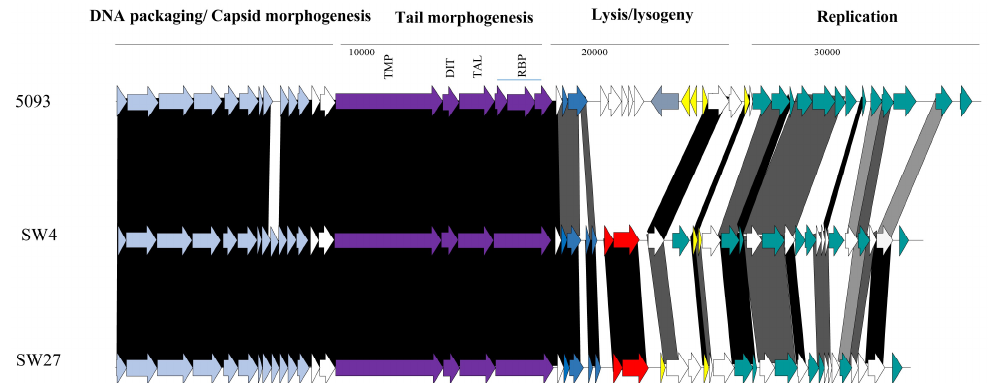
Figure 3. Genomic comparisons of representative 5093 phages from this study and the namesake of the group, 5093. The functions of the gene modules are indicated above the diagram and correspond to the colour-coded arrows as follows: pale blue arrows represent genes encoding DNA packaging and capsid morphogenesis functions; purple arrows indicate tail adhesion/injection device components including the TMP, Dit, Tal, and RBPs; dark blue arrows indicate host lysis functions; red arrows indicate the presence of transposase-encoding genes; yellow arrows represent repressor/anti-repressor-encoding genes; and teal green coloured arrows represent genes encoding predicted DNA replication functions. Where arrows are joined by a black shaded area, the represented gene products are between 90% and 100% similar at the aa level; dark grey indicates 70–89% similarity and light grey indicates 50–69% aa identity between the gene products. Unshaded regions represent those possessing less than 50% aa